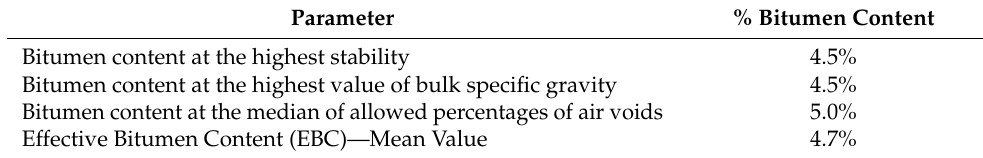
Table 7. Determination of Effective Bitumen Content (EBC).